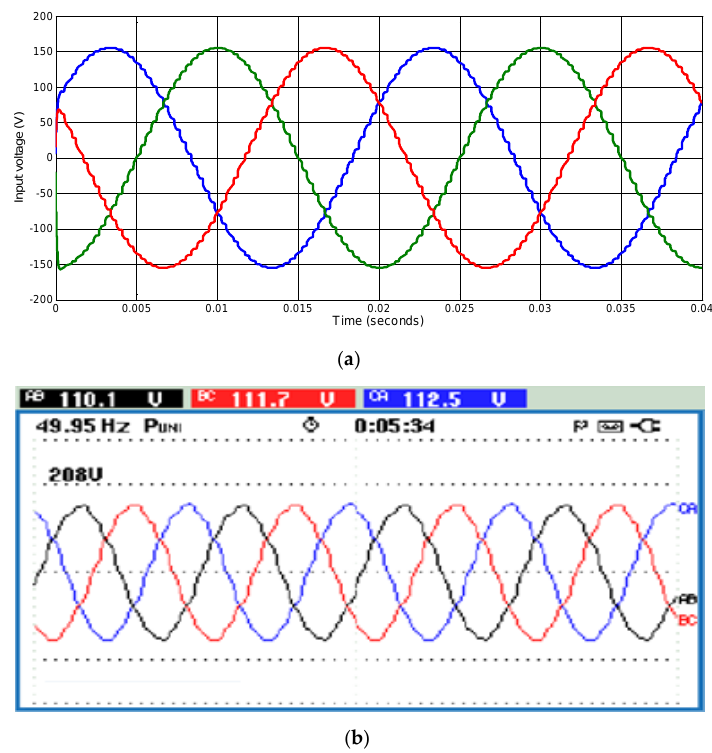
Figure 9. The three-phase AC input voltage: ( a ) simulation results, ( b ) experimental results.